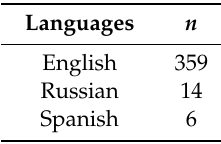
Table 2. Language of AI publications.